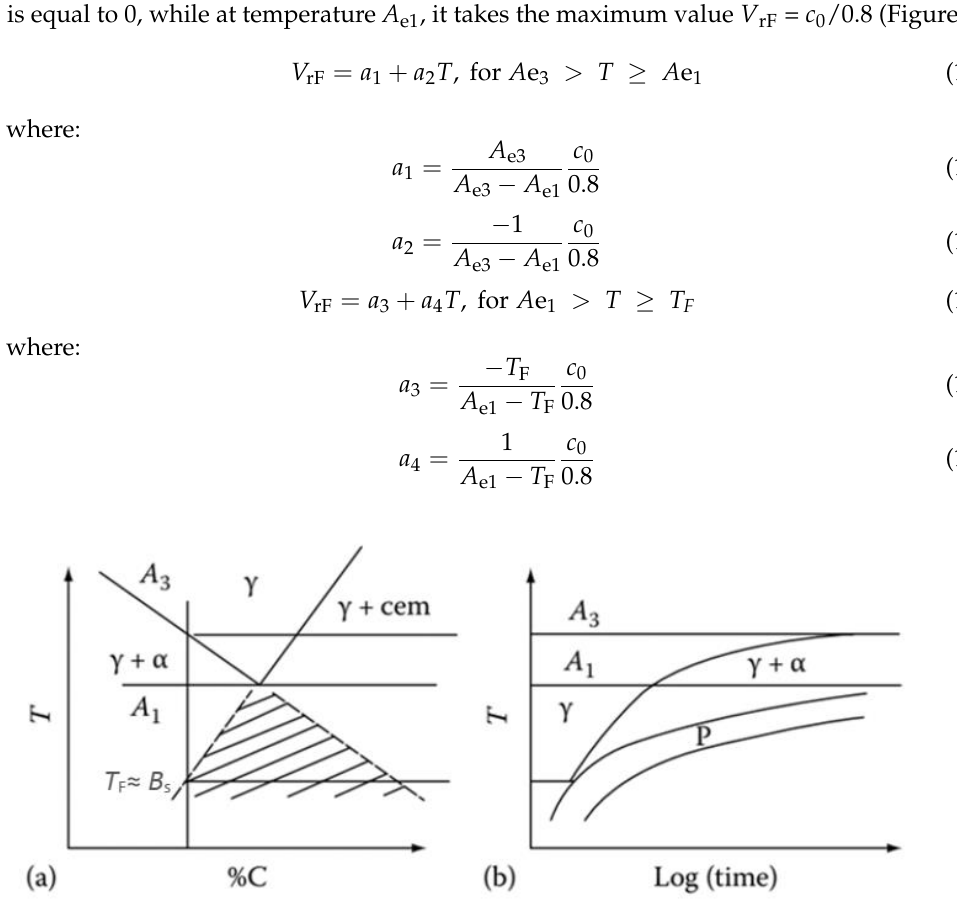
Figure 1. Effect of transformation temperature on the volume fraction of proeutectoid ferrite. ( a ) Scheme of an extension of the eutectoid field with a temperature of austenite decomposition in a Fe- C system; ( b ) scheme of a TTT diagram for hypoeutectoid steel.